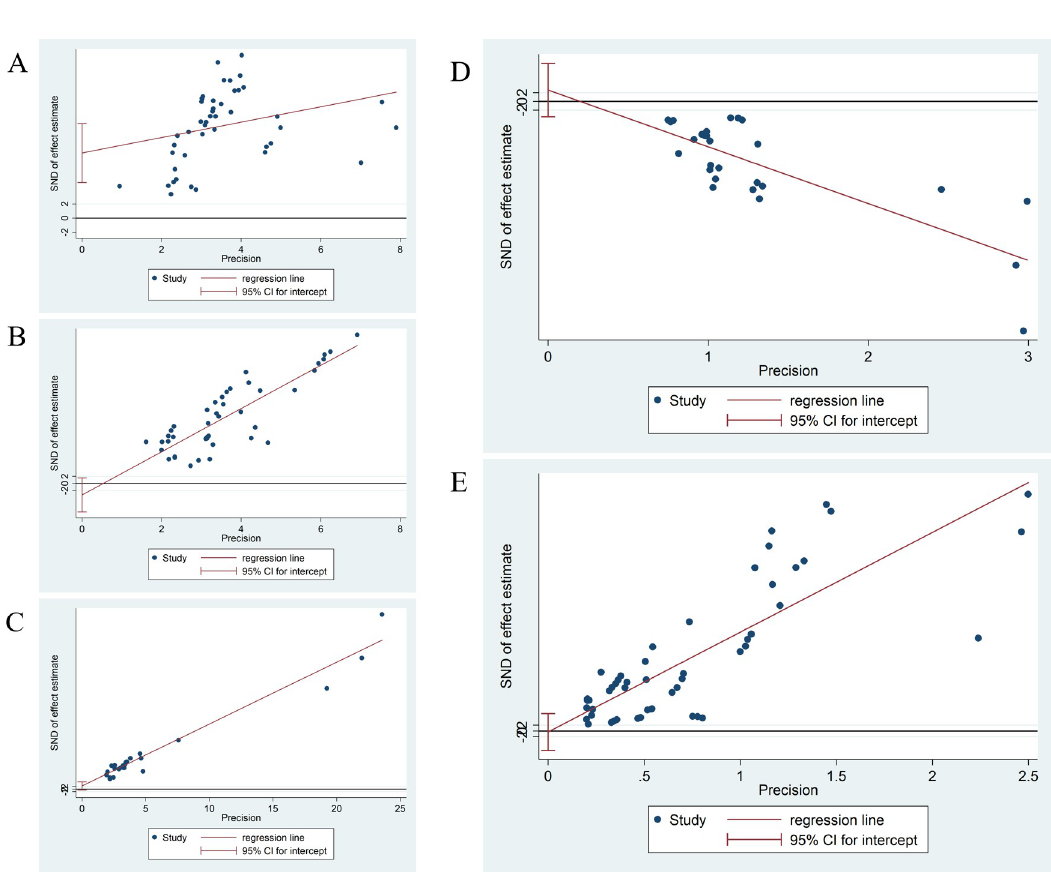
Fig 8. Egger graph of postoperative outcomes after PES. (A) Egger graph of VAS-back; (B) Egger graph of VAS-leg; (C) Egger graph of VAS-mix; (D) Egger graph of JOA; (E) Egger graph of ODI.